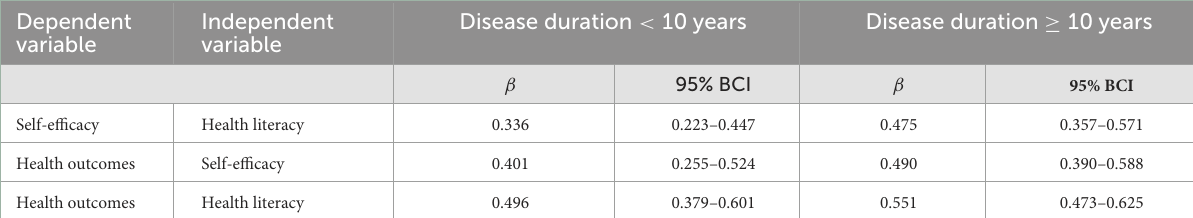
TABLE 3 The moderating effect of disease